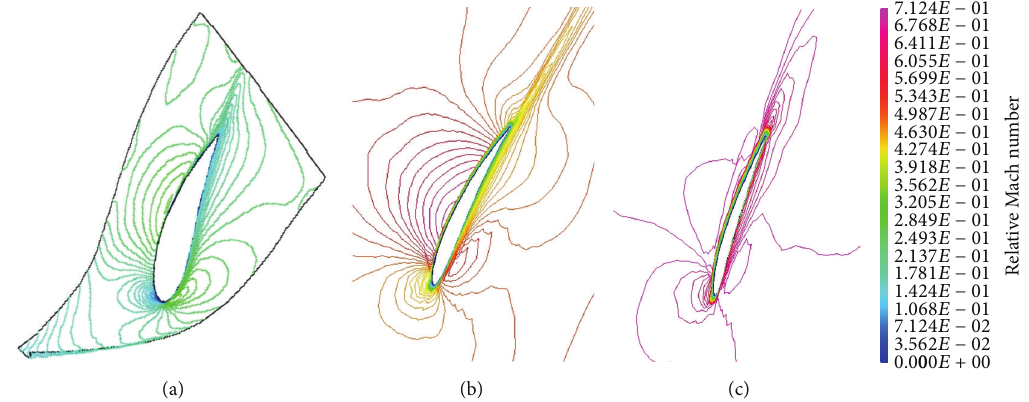
Figure 5: Relative Mach number (a) near hub, (b) at 𝑅75 , and (c) at tip.